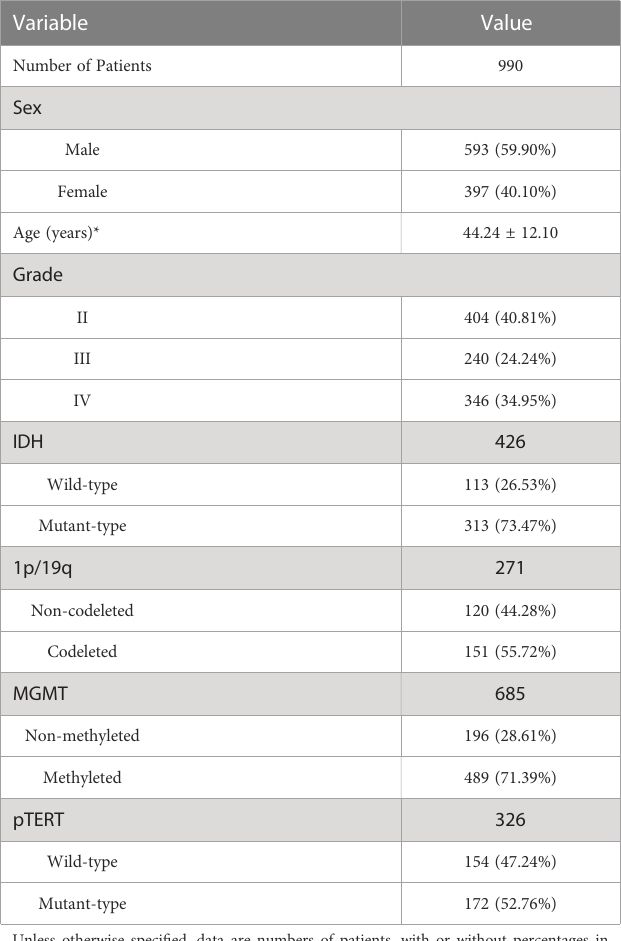
TABLE 1 Baseline demographics and pathological characteristics of patients.